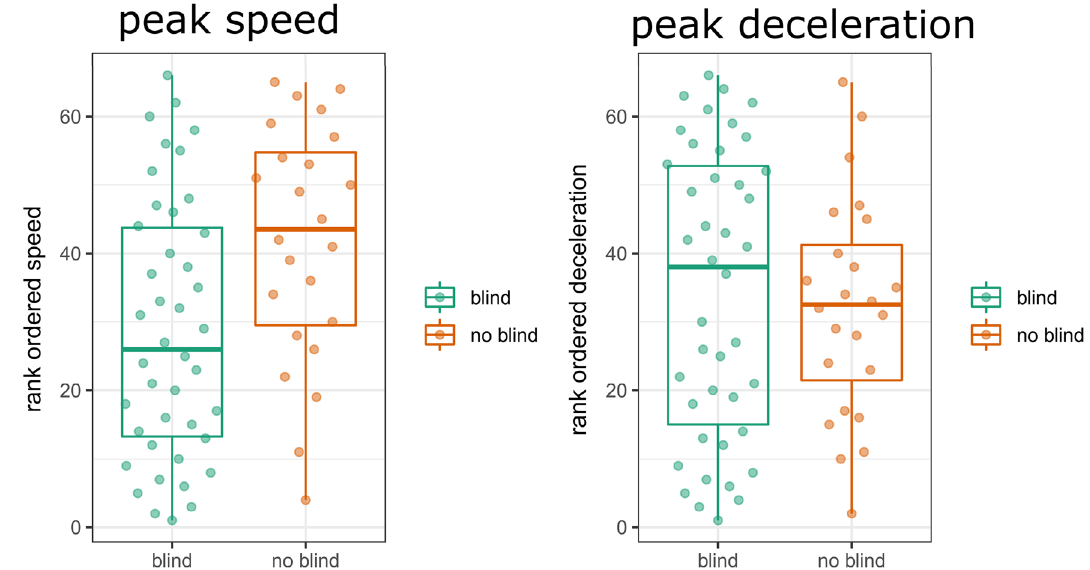
Figure 6. Differences in peak speeds and peak deceleration per condition. Note . The left panel shows the observed rank ordered peaks in speed for the blind versus the no blind condition, and the right panel shows this for peaks deceleration.